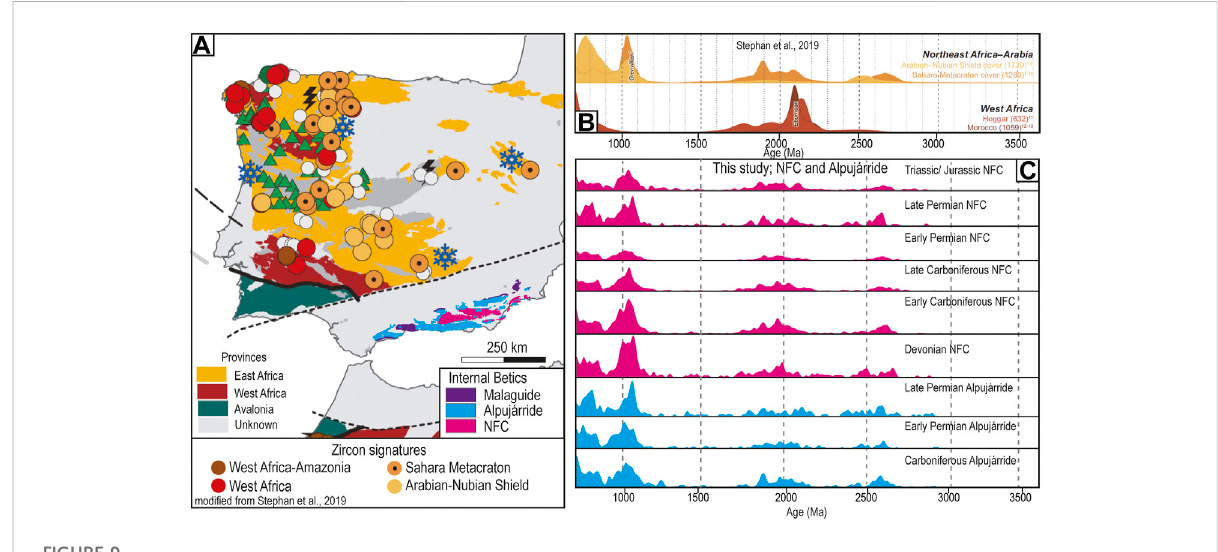
FIGURE 9 (A) Modi fi ed from Stephan et al. (2019) showing the different provenance signatures in Iberia; gray areas on the initial map indicate unknown/ unconstraint areas. Purple, light blue, and pink indicate the units of the internal Betics. (B) Compilation from Stephan et al. (2019) from zircon U-Pb KDE plots from the East and West African provinces. (C) Zircon U-Pb KDE from this study with pink indicating samples from the NFC and light blue from